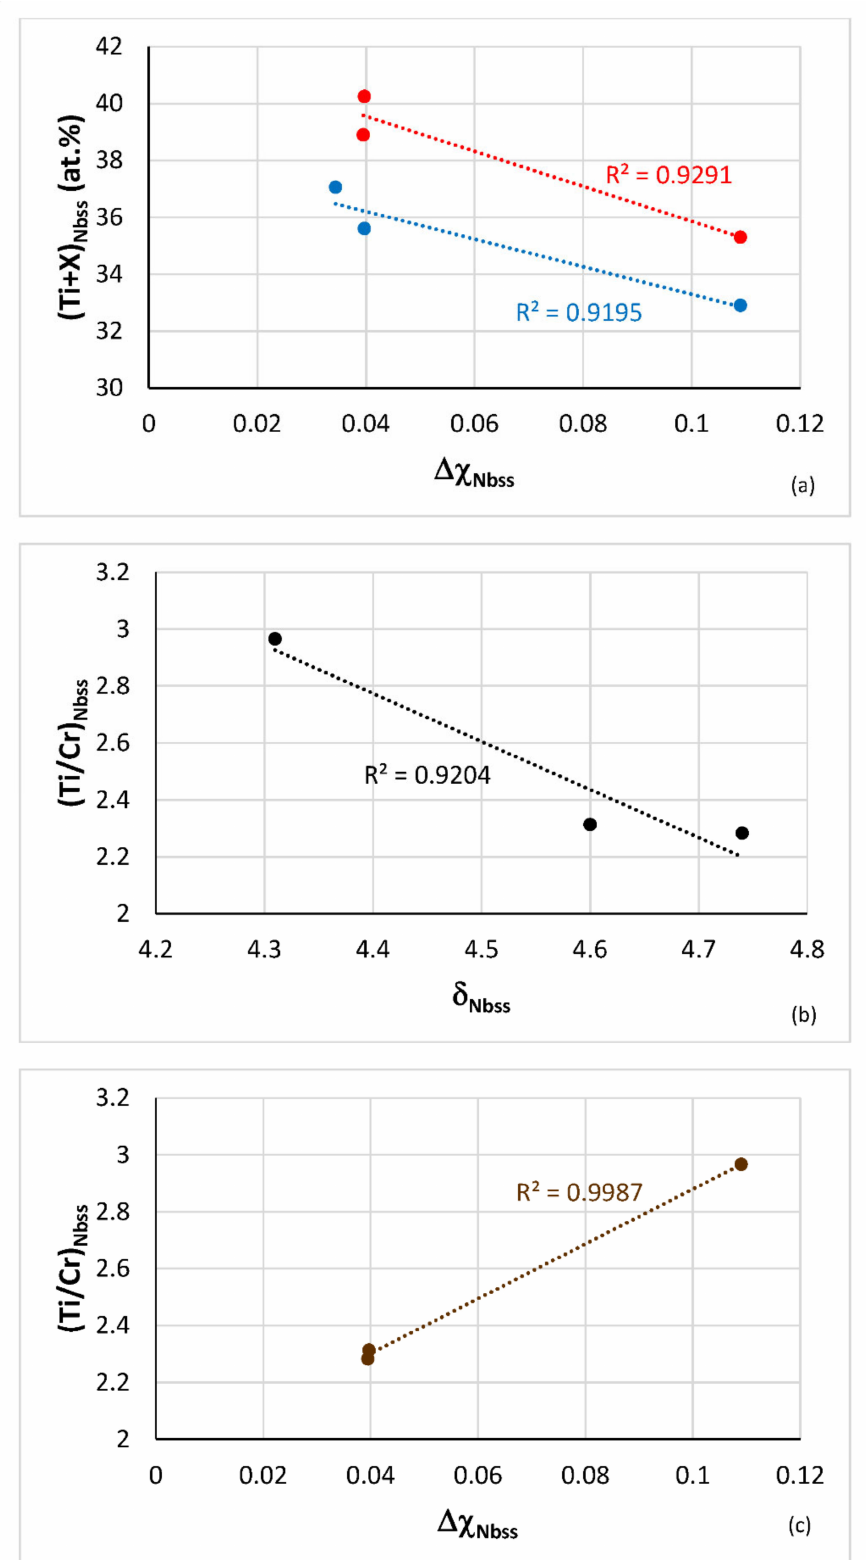
Figure A1. Data for the Nb ss in HT boron free alloys KZ4, KZ5, KZ7 and JG3. ( a )Ti + X (X = Al (blue), Cr (red)) versus the parameter ∆ χ for the alloys KZ4, KZ5, KZ7 and JG3, ( b ) and ( c ) Ti/Cr versus ( b ) δ for the alloys KZ4, KZ5 and JG3 and ( c ) ∆ χ for the alloys KZ7, KZ5 and